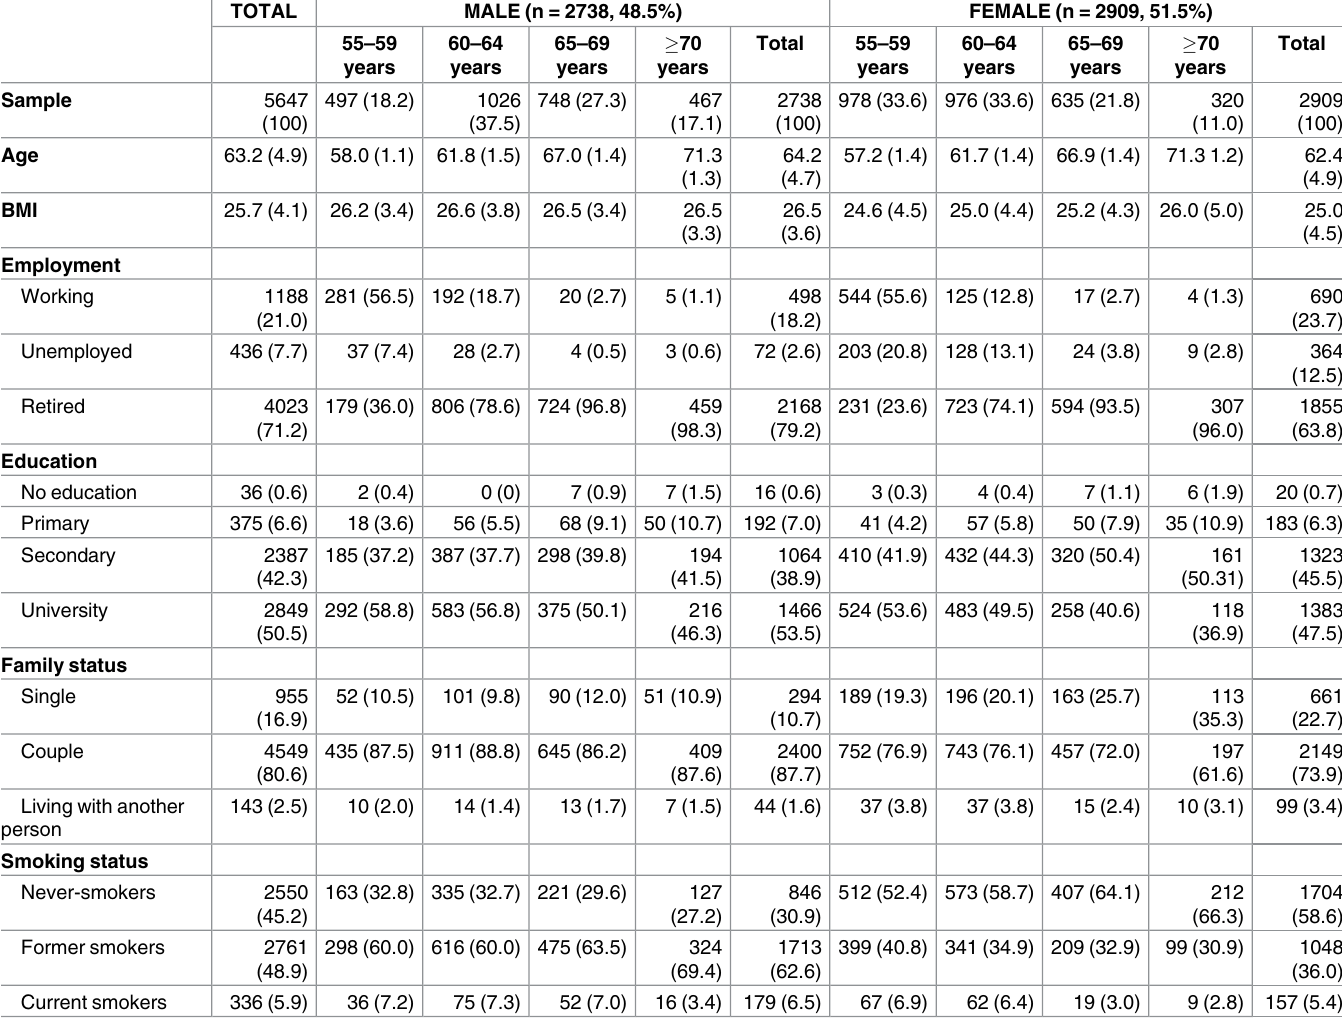
Table 1. Description of participants aged 55 years or older in the SU.VI.MAX 2 study by gender and age group. TOTAL